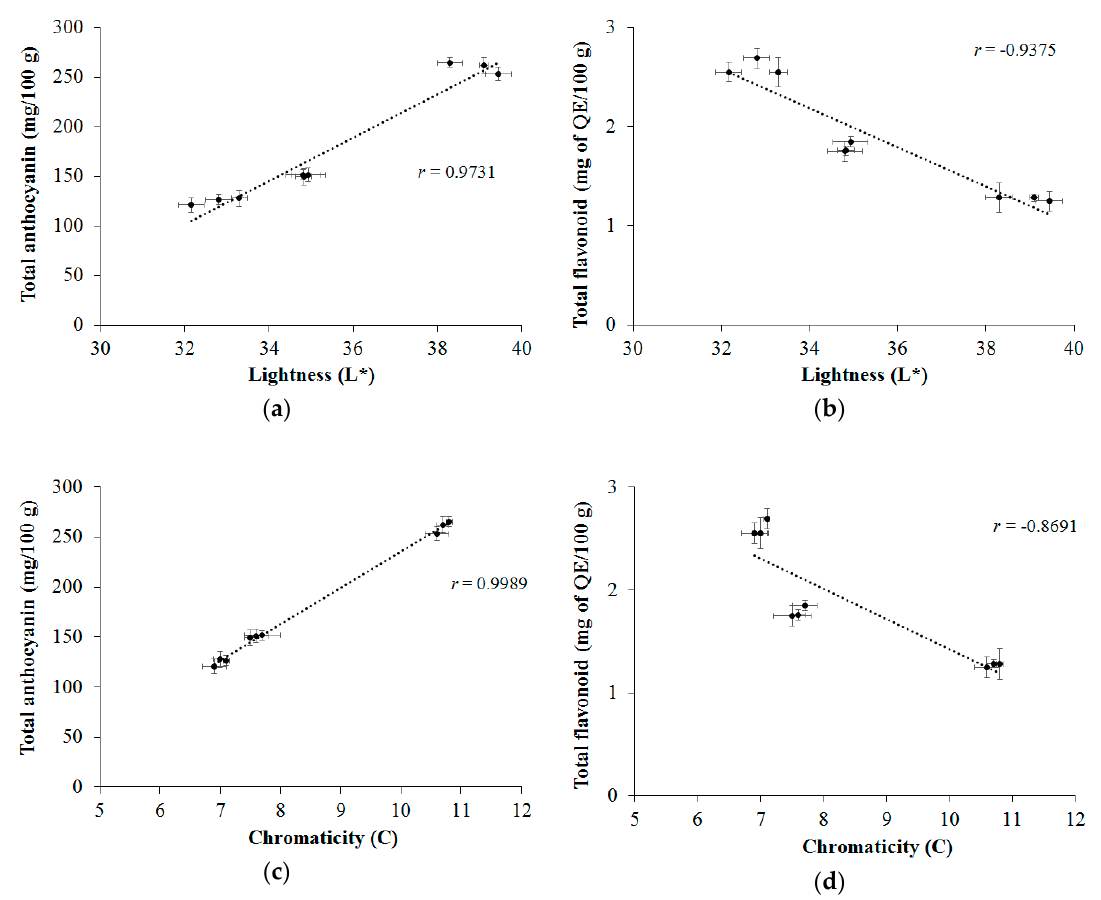
Figure 2. Correlations between: luminosity and TAC ( a ), luminosity and TFC ( b ), chromaticity and TAC ( c ) and chromaticity and TFC ( d ). The values of mean ± standard deviation (SD) correspond to averages from three samples.